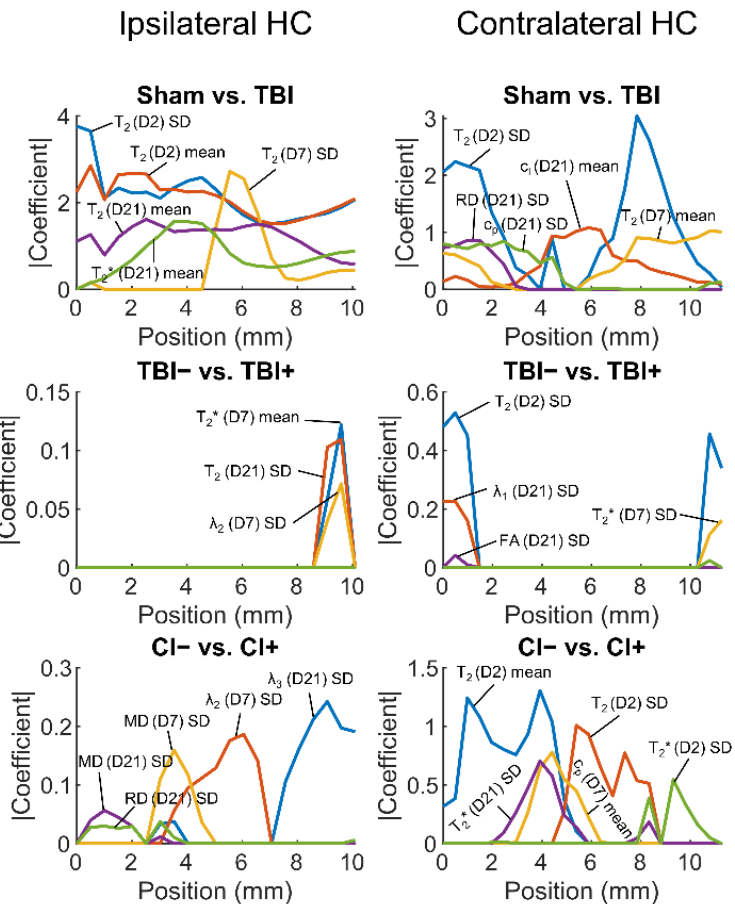
Figure 7. The most important predictors in logistic regression models. The predictors were normal- ized (mean 0, SD 1) before model fitting so that the absolute values of their estimated coefficients reflected their importance. Then, the estimated coefficients were averaged over the cross-validation folds. Five predictor variables with the highest absolute coefficients ( y -axis) at any point along the hippocampus ( x -axis) were selected. Abbreviations: CI − , rats without cognitive impairment; CI+, rats with cognitive impairment; D, day; FA, fractional anisotropy; HC, hippocampus; MD, mean diffusivity; RD, radial diffusivity; SD, standard deviation; TBI, traumatic brain injury; TBI − , rats without epilepsy; TBI+, rats with epilepsy.